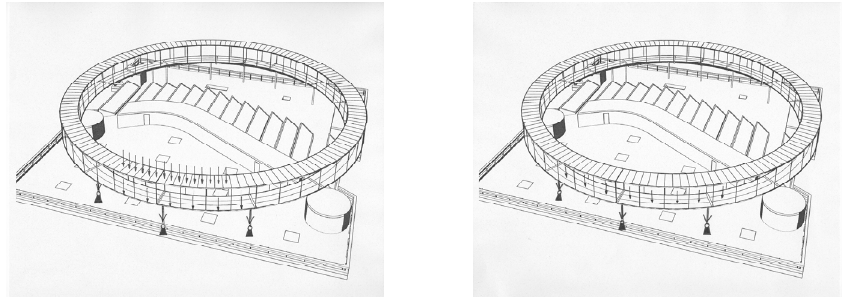
Figure 7: Transfer of vertical loads on the roof and dead loads from the glass walls; left: dead loads, snow loads and wind loads on the roof; right: live loads on the floor surface of the box girder .